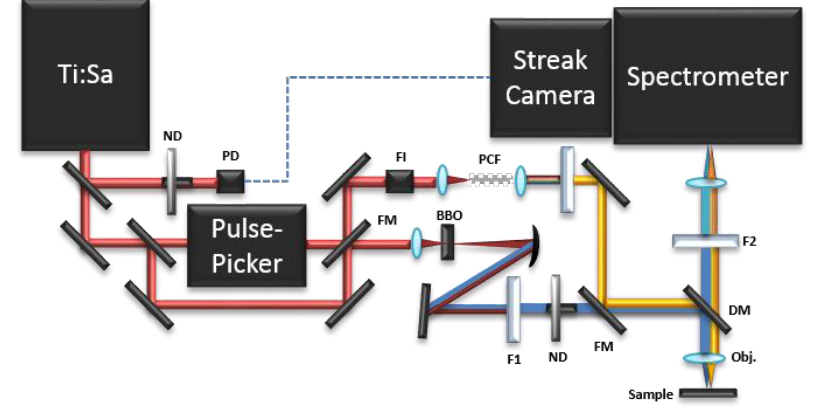
Figure 2. The TRPL setup. ND: neutral density attenuator; PD: photodiode; FI: Faraday isolator; PCF: photonic crystal fiber; FM flipping mirror; BBO: type I β-barium borate crystal; F1: low pass filter; DM: dichroic mirror; Obj.: microscope objective; F2: high pass